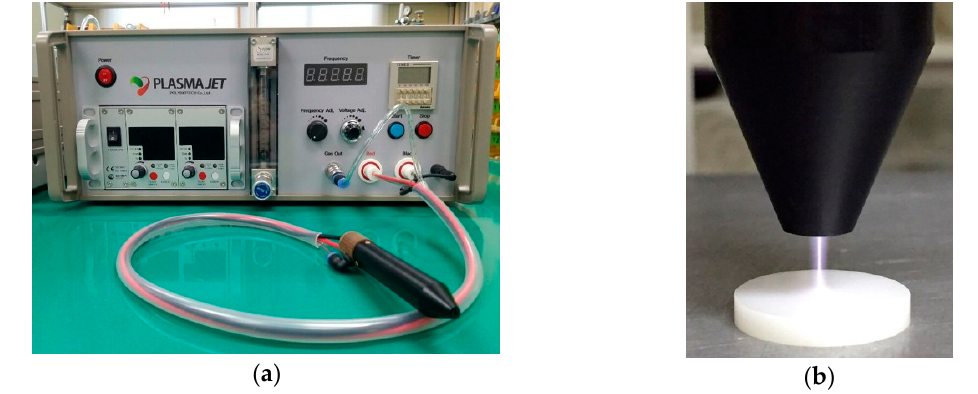
Figure 1. Non-thermal atmospheric plasma generator: ( a ) Frontal view; ( b ) Plasma treatment of a zirconia